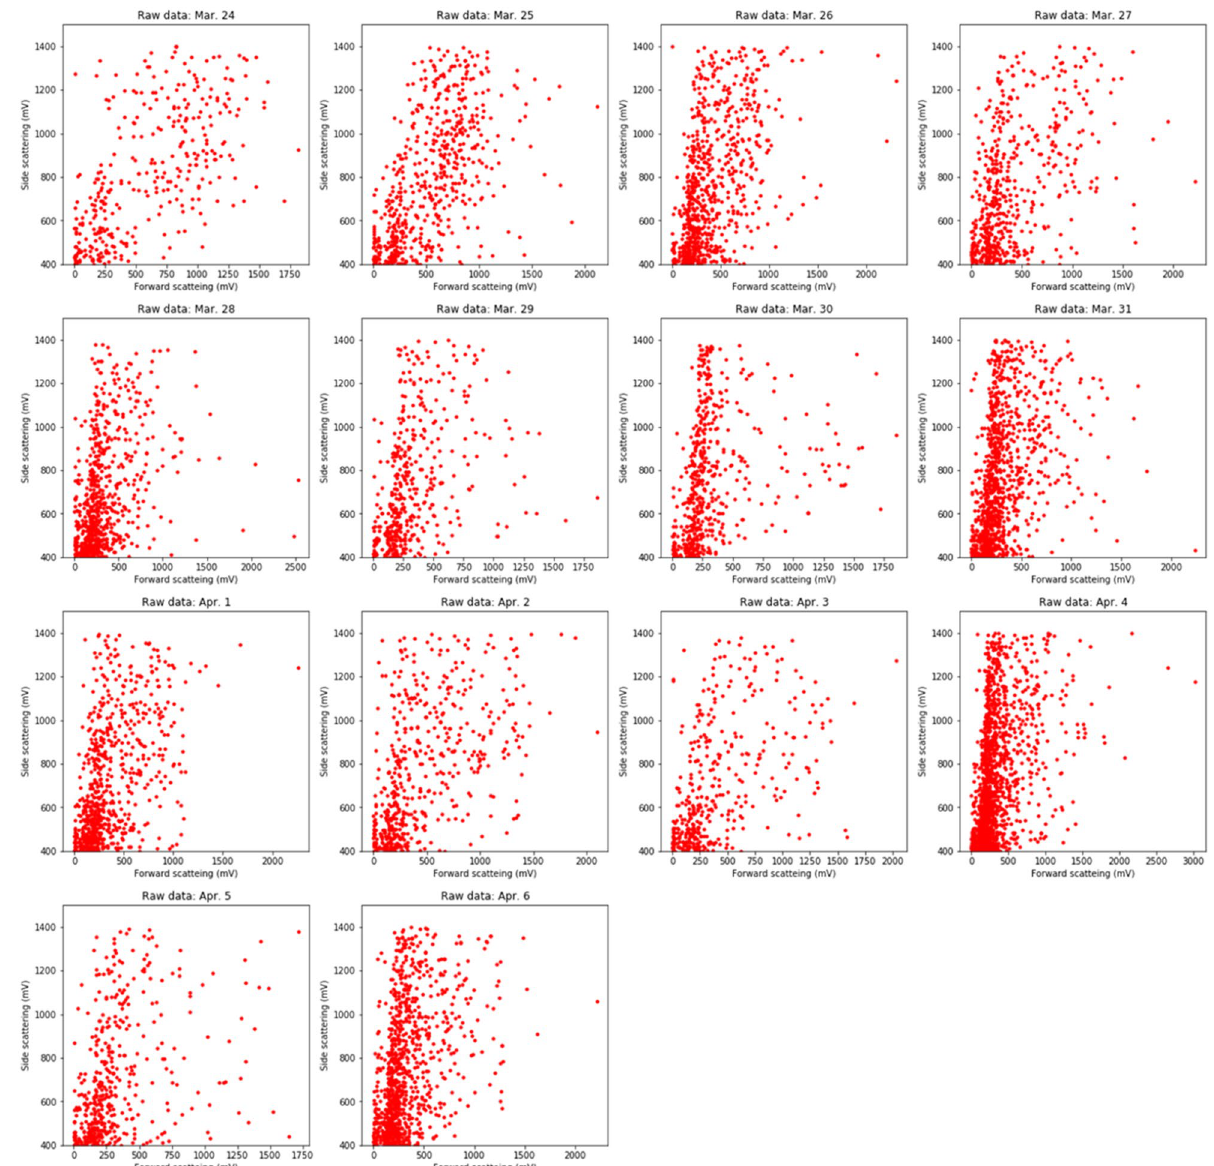
Figure 3. Field data from the KH-3000-01. Side-scattering data in the range of < 400 to > 1400 mV were excluded to avoid interference from dust